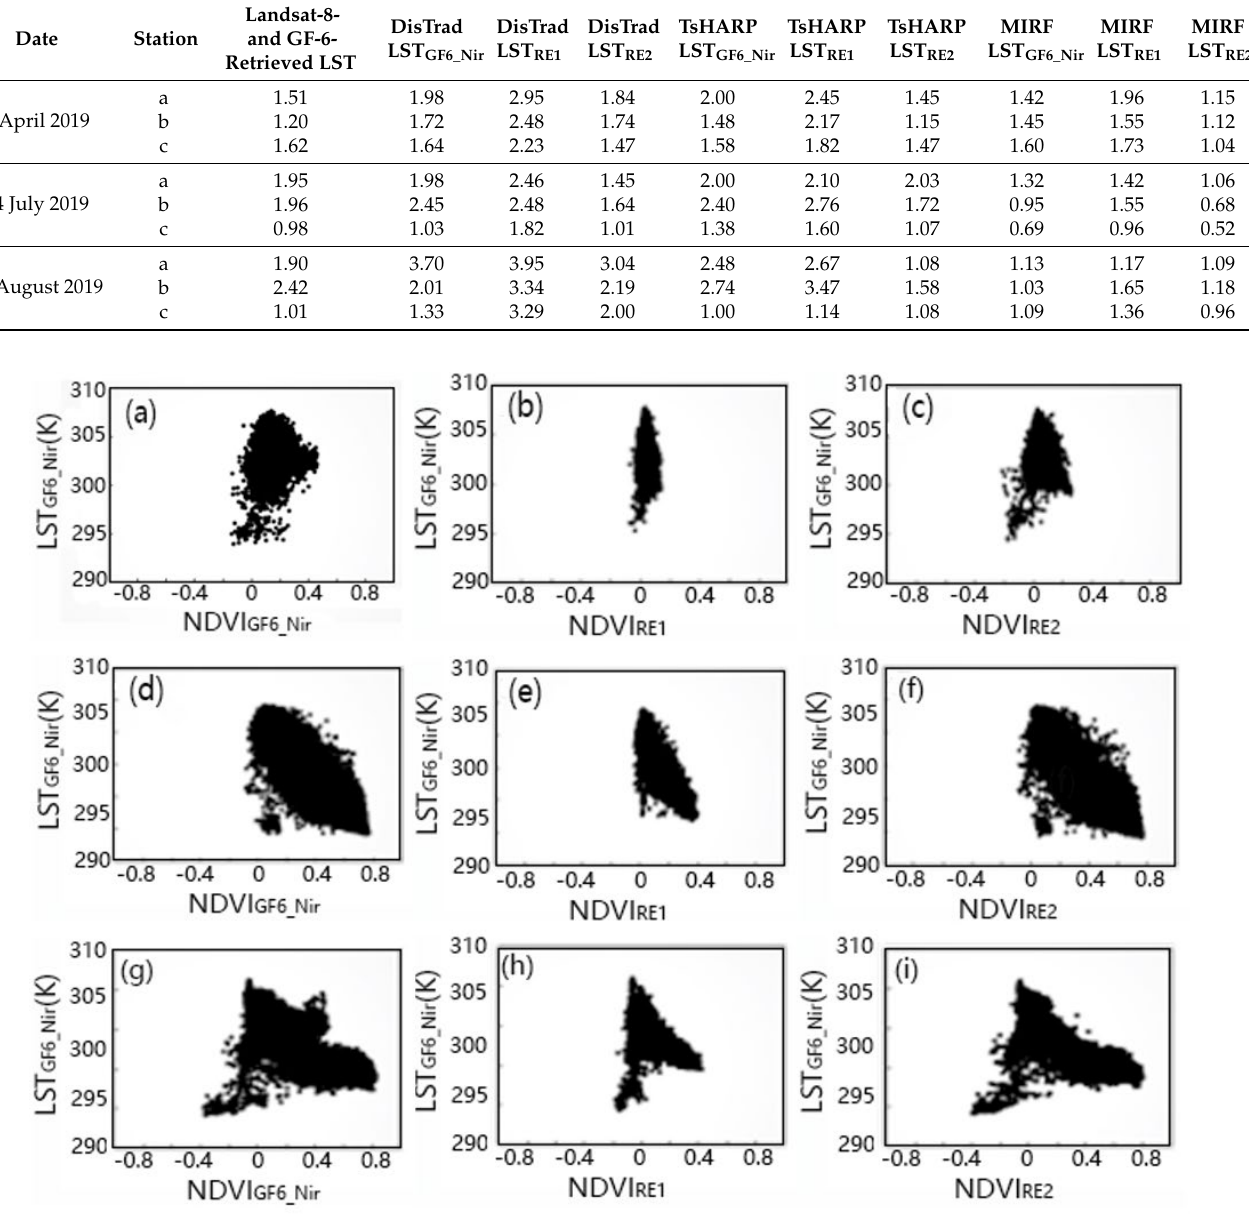
Figure 11 . Scatter distribution of three NDVI and the corresponding LST. ( a ) NDVI GF-6_Nir and LST on 9 April 2019, ( b ) NDVI RE1 and LST on 9 April 2019, ( c ) NDVI RE2 and LST on 9 April 2019, ( d ) NDVI GF-6_Nir and LST on 24 July 2019, ( e ) NDVI RE1 and LST on 24 July 2019, ( f ) NDVI RE2 and LST on 24 July 2019, ( g ) NDVI GF-6_Nir and LST on 26 August 2019, ( h ) NDVI RE1 and LST on 26 August 2019, ( i ) NDVI RE2 and LST on 26 August 2019.